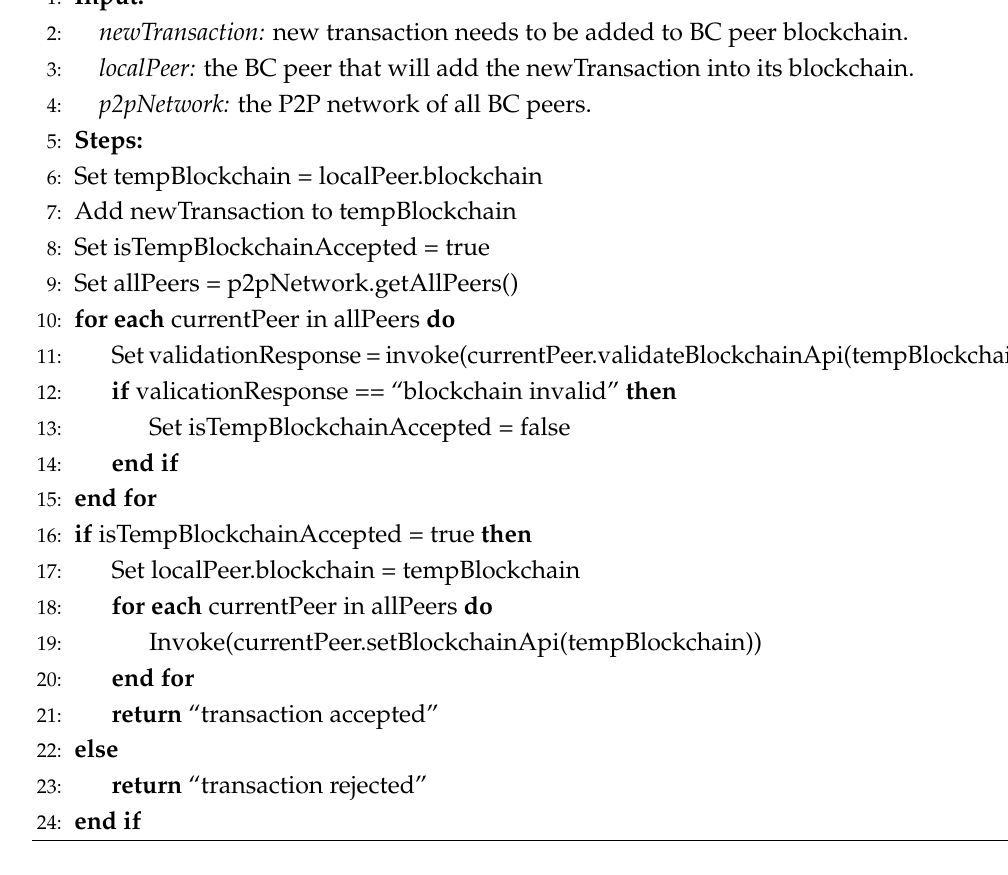
Algorithm 1 Add transaction to blockchain of BC